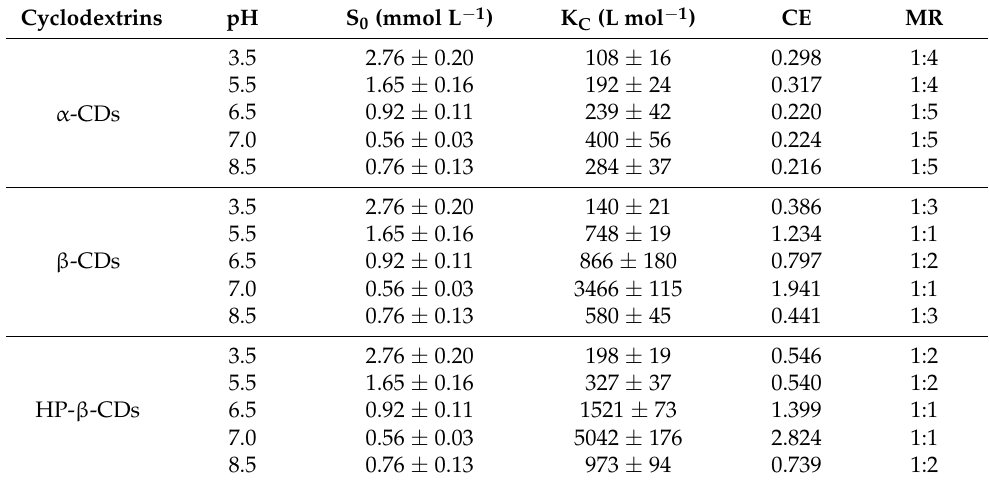
MR: molar ratio. Values are the means of three